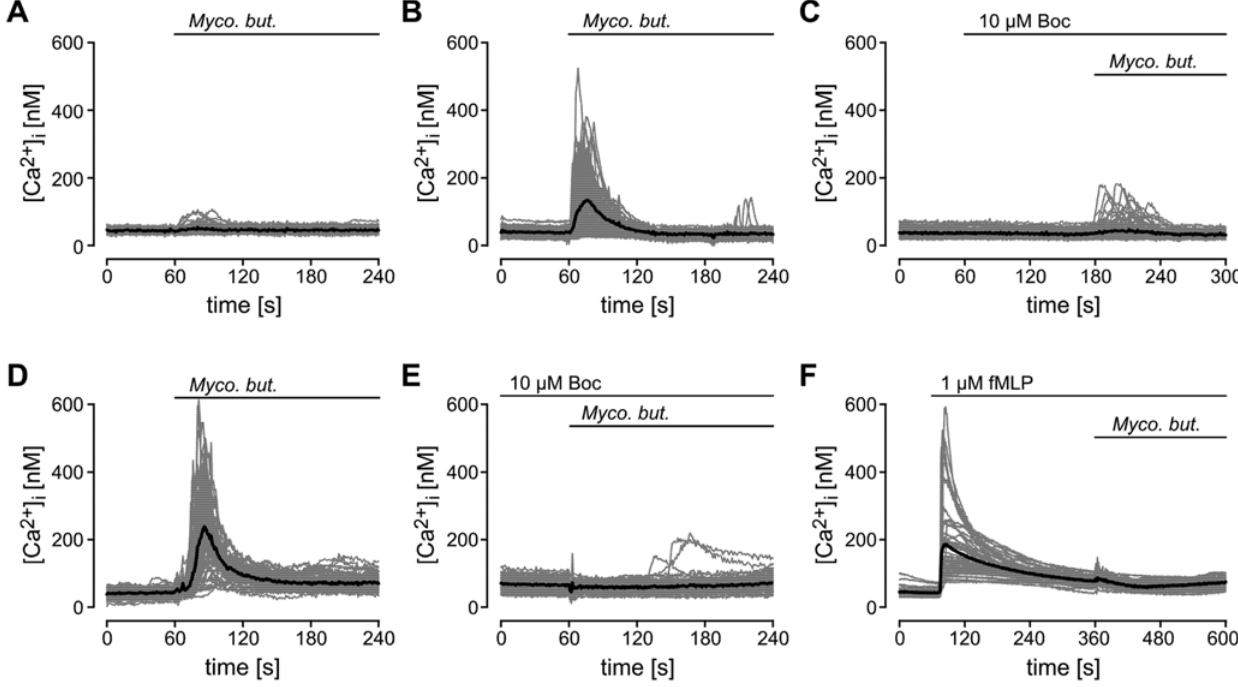
Figure 5. Mycobacterium butyricum-triggered intracellular calcium elevation is FPR dependent. Mock [ A ] or human FPR [ B,C ] transfected HEK293 cells or human neutrophils [ D–F ] were loaded with Fura-2. Changes in [Ca 2 + ] i were analyzed after addition of Mycobacterium butyricum ( Myco. but. ) at 60 s in the presence [ C, E ] or absence [ B,D ] of 10 m M Boc-FLFLF (Boc). [ F ] Impact of fMLP stimulation on subsequent stimulation with Mycobacterium butyricum in human